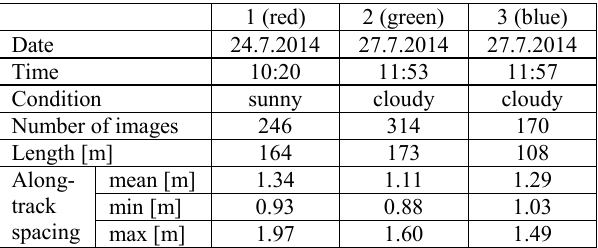
Table 1. Characteristics of the three selected image sequences